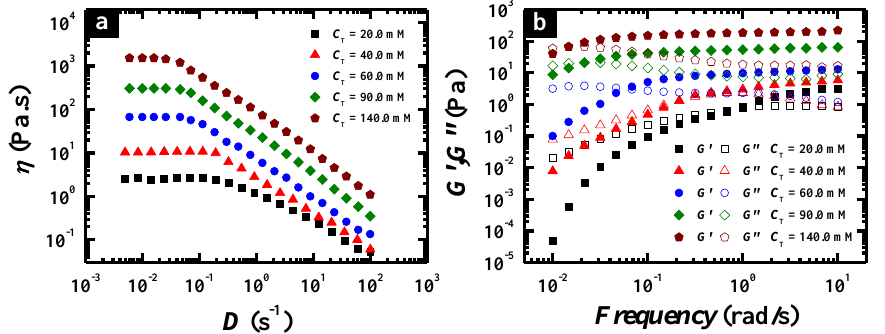
Figure 4. Steady ( a ) and dynamic ( b ) rheological properties of C 12 C 3 C 12 (SO 3 ) 2 solutions at different concentrations, and the total concentration is 20.0, 40.0, 60.0, 90.0 and 140.0 mM, respectively.